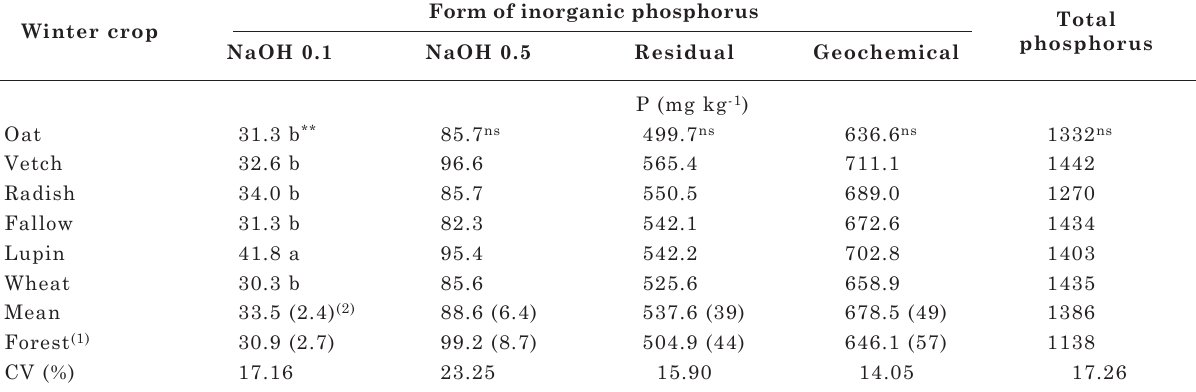
table 8. Forms of inorganic phosphorus and total phosphorus after 23 years of different winter crops of a rhodic hapludox